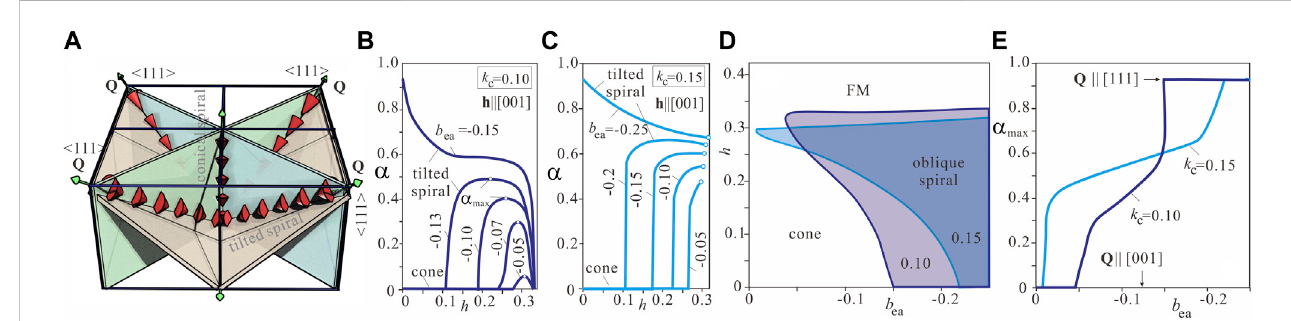
FIGURE 3 (color online) (A) Schematics showing coexisting conical and tilted spiral states. TS forms four energetically equivalent domains canting towards 〈 111 〉 directions. Magnetic fi elddependenceoftheangle α for k c =0.1 (B) and k c =0.15 (C) withavaryingvalueoftheexchangeanisotropy b ea .In (B) ,thetiltedspiral almost returns back to the direction of the fi eld, whereas in (C) , being de fl ected from the fi eld by quite a large angle α , it undergoes the fi rst-order phase transition with respect to the homogeneous state. (D) The diagram showing the regions where the conical and tilted spiral states possess the lowest energy density among all one-dimensional spiral modulations. The light-blue area stands for k c = 0.15, and the dark-blue shaded area — for k c = 0.10. (E) The dependenceofthe α max de fi nedin (B) ontheexchangeanisotropyvalueforthesametwocubicanisotropyconstants.For k c =0.15,thisdependenceexhibitsa plateau with almost constant angle, which becomes smaller at k c = 0.1 and steepens its slope. At some critical value of k c (e.g., for k c = 0.05), one would observe just a jump between two angle values corresponding to [001] and 〈 111 〉 axes.